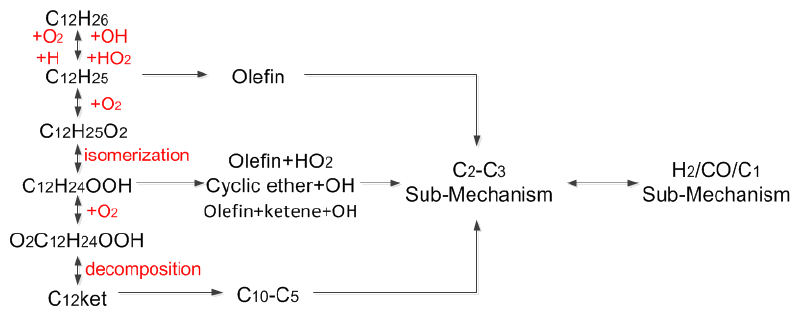
Figure 4. Main reactions pathway of n-dodecane oxidation.